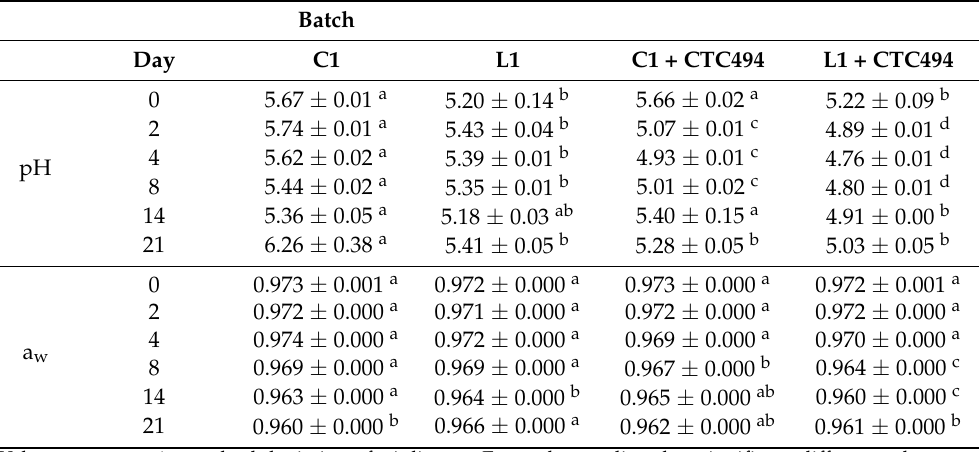
Values are mean ± standard deviation of triplicates. For each sampling day, significant differences between batches are indicated by different superscript letters ( p < 0.05).